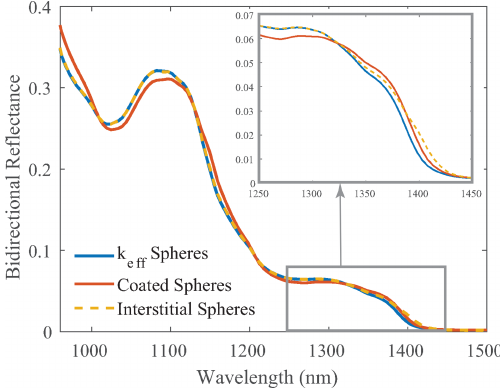
optical mixing models: (1) k eff spheres, (2) coated spheres, and (3) interstitial spheres. For comparison, each mixing model has an effective grain radius of 1000µm and 20% liquid water content by